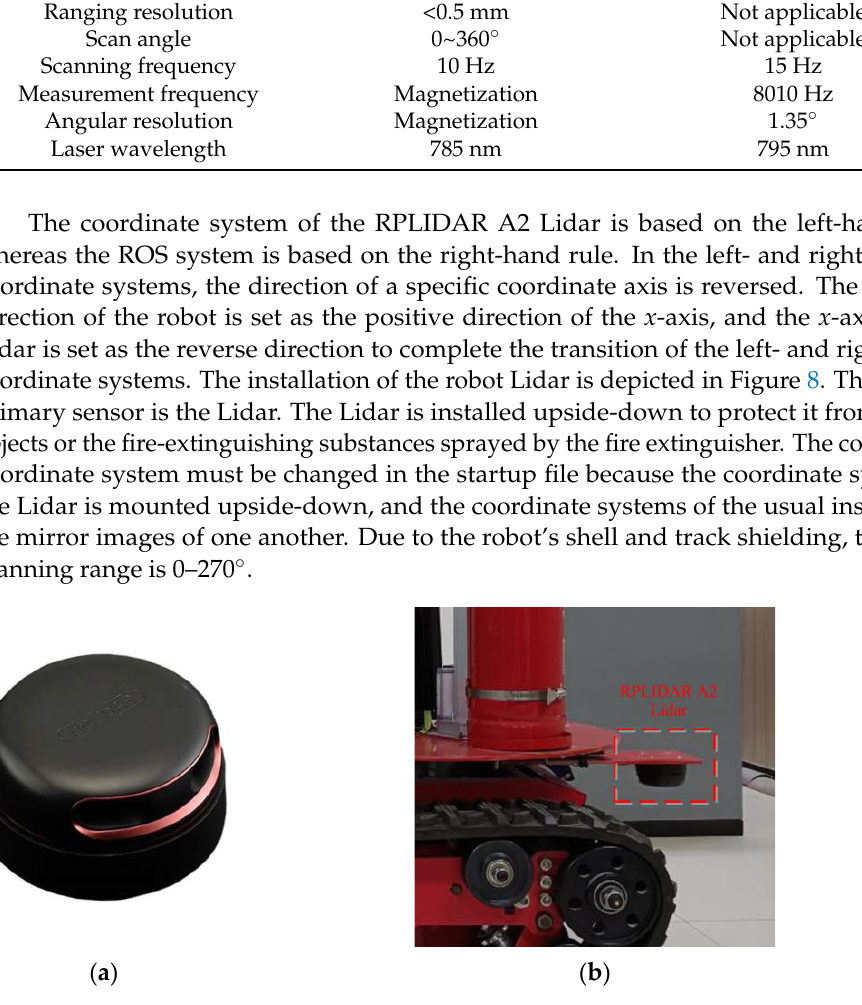
Figure 8. Lidar mounted upside-down on the robot: ( a ) Lidar. ( b ) Lidar mounted on the robot.